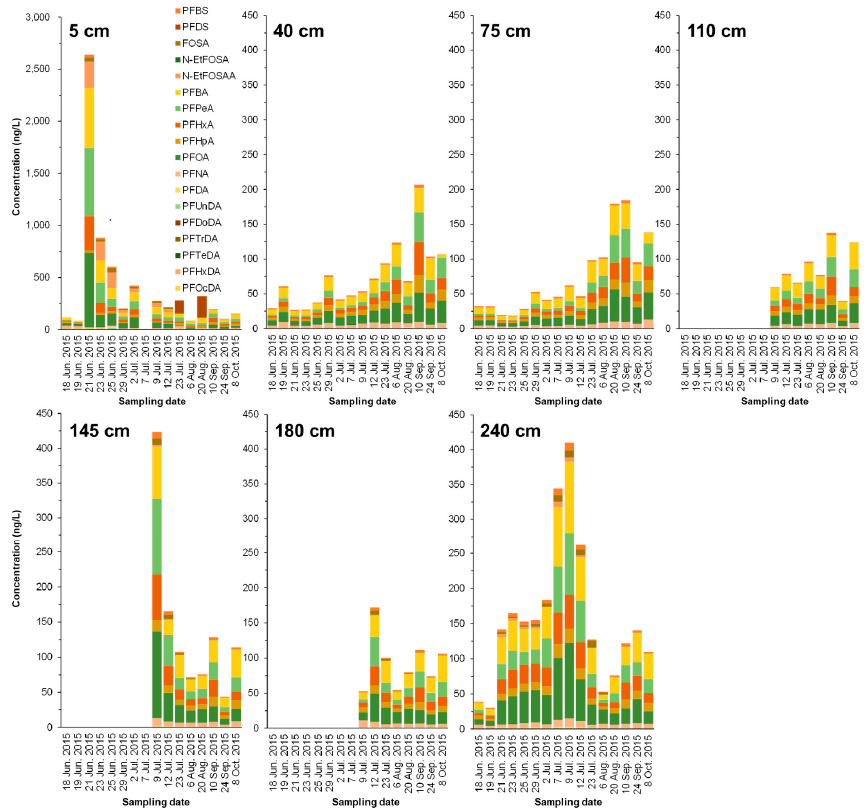
Figure 3. Time-course change of PFAS concentrations (ng/L) in lysimeter leachate collected from different depths (5, 40, 75, 110, 145, 180, and 240 cm). The leachate samples could not be obtained for all sampling dates.